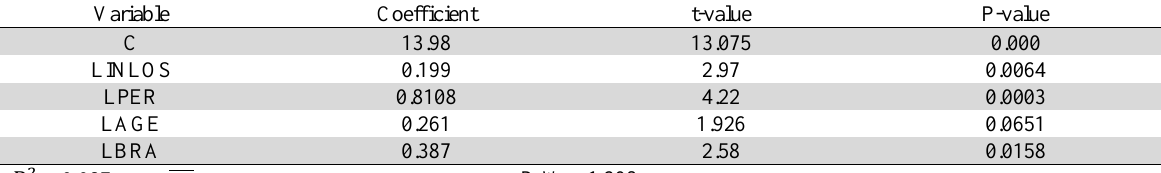
The summary of regression analysis of LERP as a function of LINLOS, LPER, LAGE and LBRA